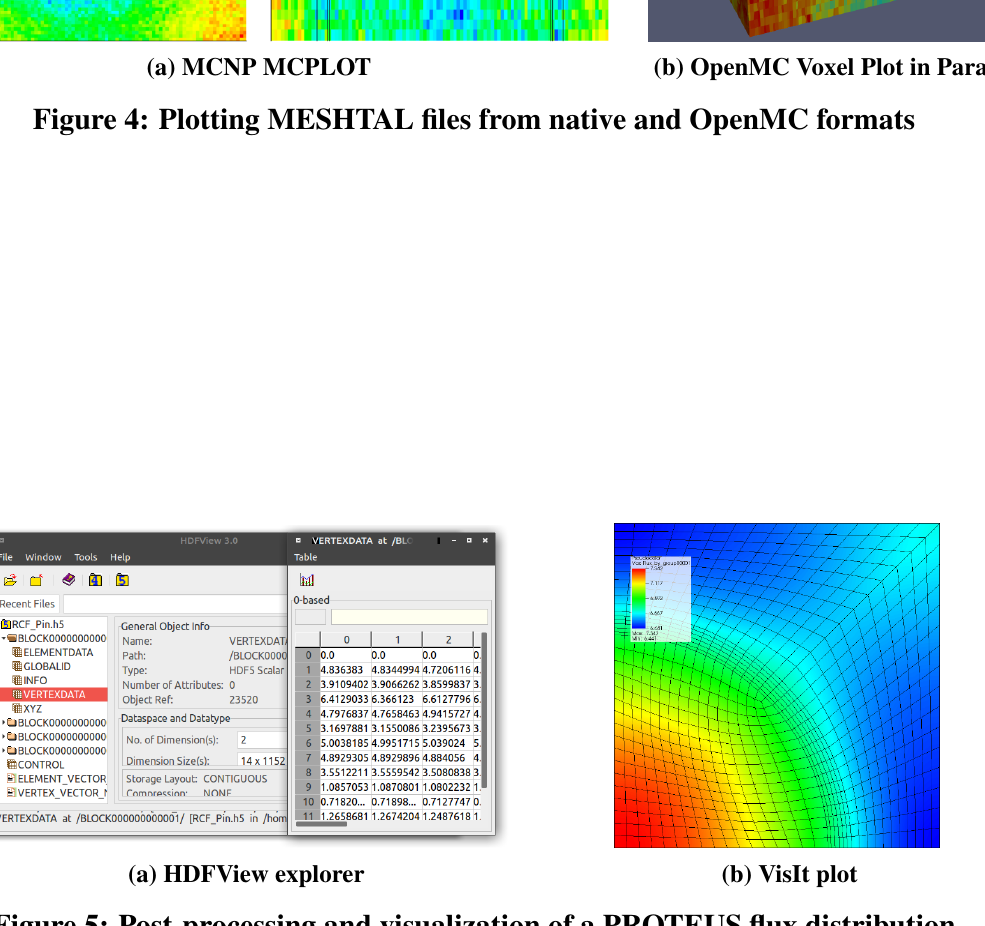
Figure 5: Post-processing and visualization of a PROTEUS flux